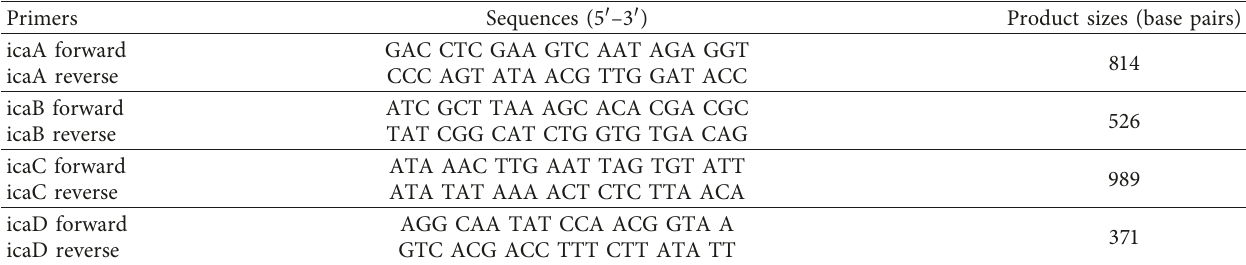
T ABLE 1: Primers used for amplification of the adhesin genes of Staphylococcus aureus [18]. Primers